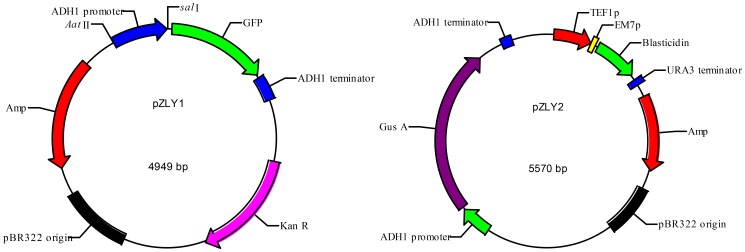
Structures of the pZLY1 plasmid (left) with the G418 resistance gene (KanR) and adh1P–GFP–adh1t reporter gene, and the pZLY2 plasmid (right) with the blasticidin resistance gene (bsd) and adh1P–gusA–adh1t reporter gene.
adh1P and adh1t represent, respectively, the promoter and terminator of the adh1 gene of Saccharomyces cerevisiae. KanR represents the G418 resistance gene, gusA represents the gusA gene and GFP represent the GFP gene.